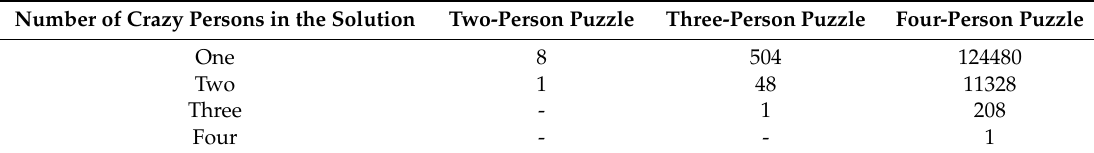
Table 5. The number of good SSS-puzzles with one, two, three or four Crazy persons in the solution. Number of Crazy Persons in the